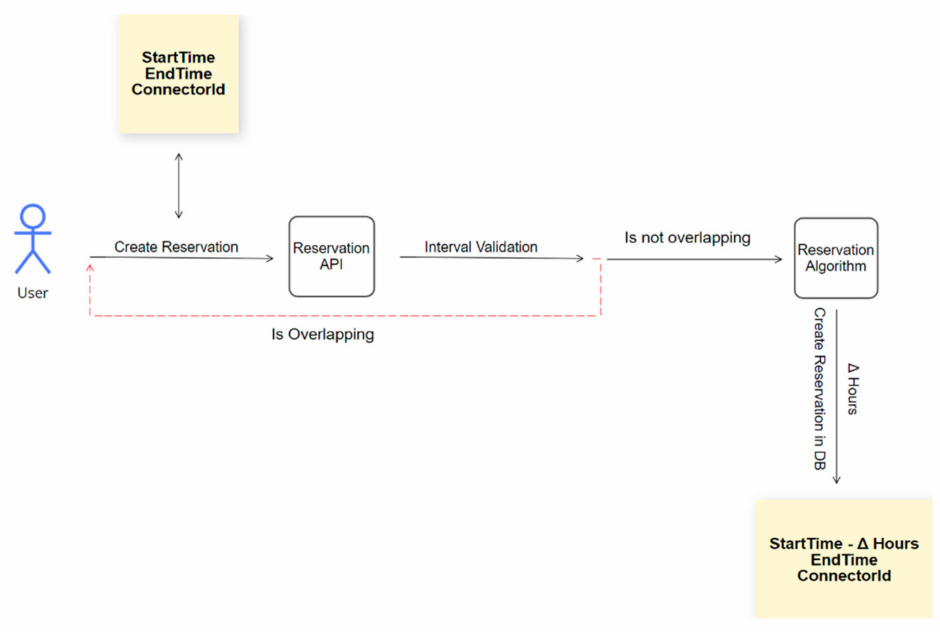
Figure 3. Reservation